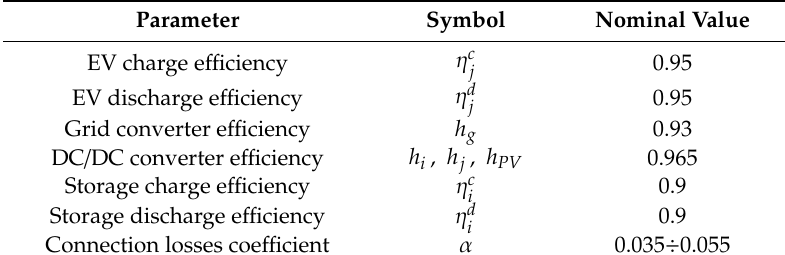
Table 2. Test system. Nominal Parameters.